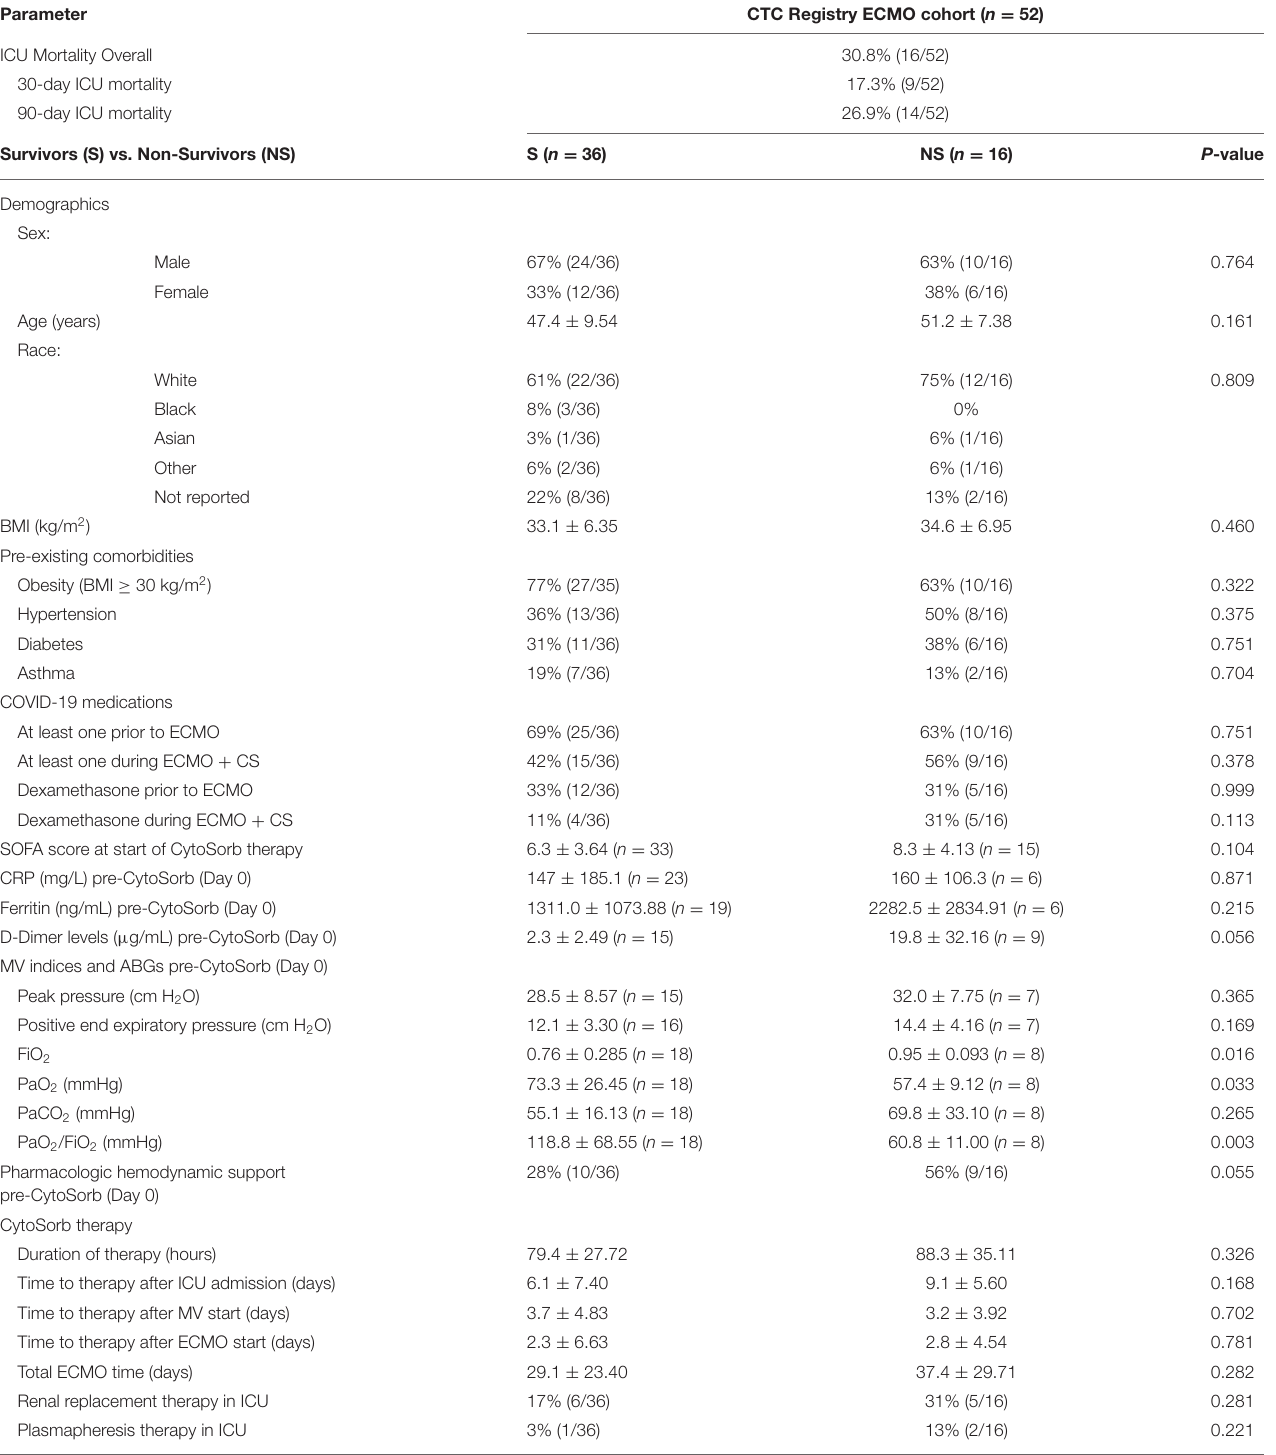
TABLE 2 | ICU mortality outcomes in the ECMO cohort.